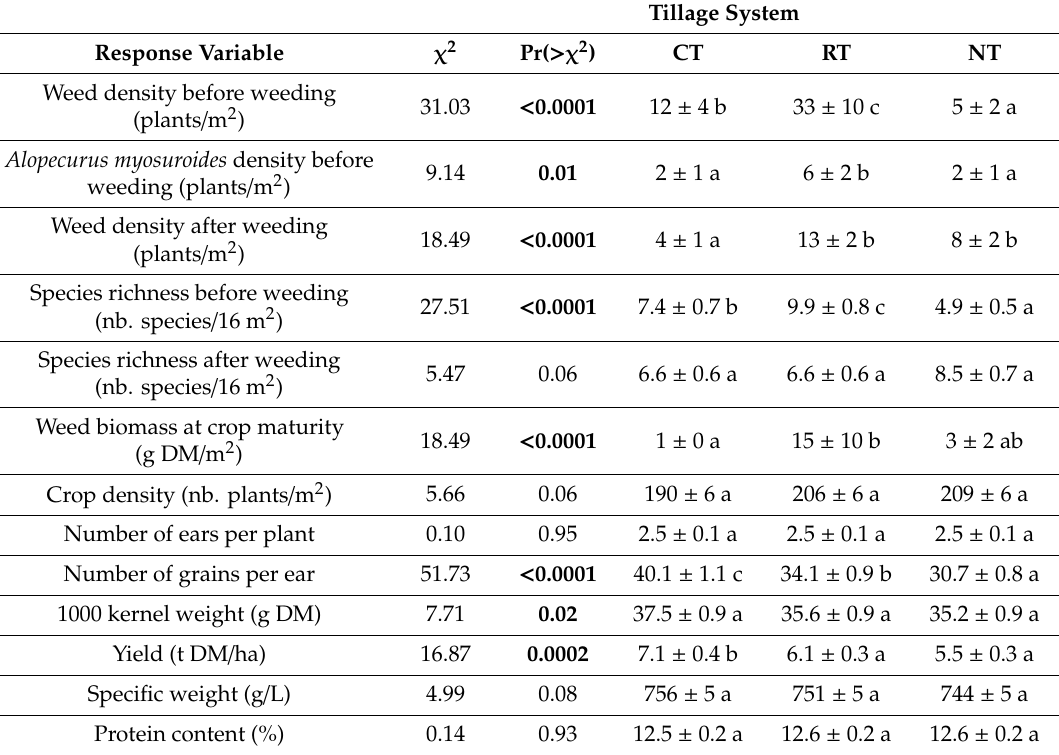
Table 1. Effect of tillage treatments (CT: conventional tillage, RT: reduced tillage, NT: no-till) implemented prior to winter wheat sowing in fields conducted under CA principles during 17 years, on weeds (density, richness, biomass), winter wheat yield and grain quality (least square mean ± standard error). Tillage systems sharing identical letters are not significantly different at p < 0.05 (bold). DM: dry